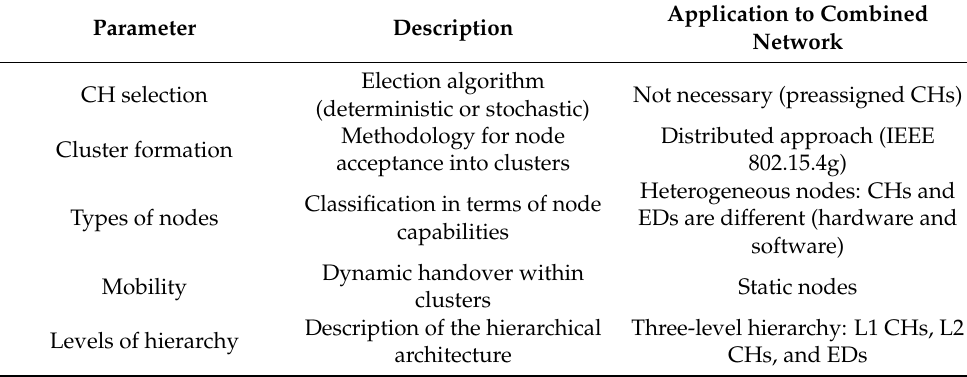
Table 6. Configuration of clustering main parameters in the context of the combined